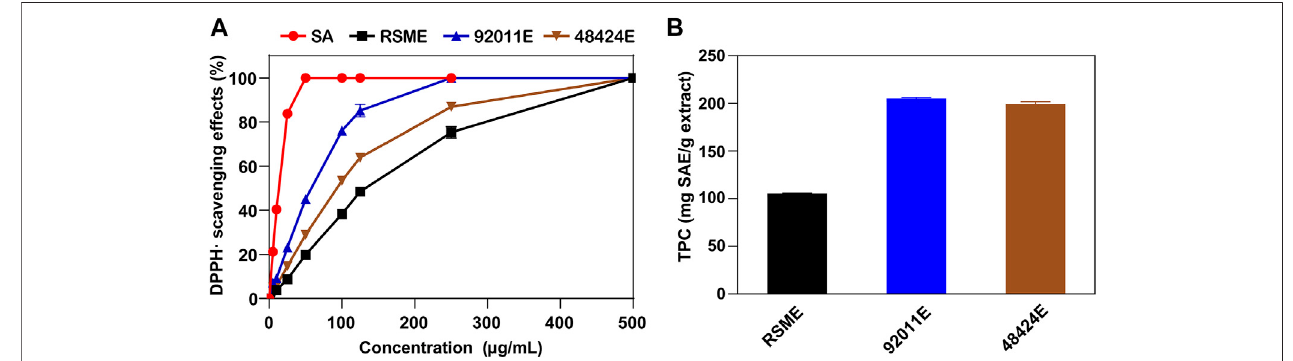
FIGURE 1 | Scavenging effects on DPPH radicals (A) and TPC (B) of three phenolic